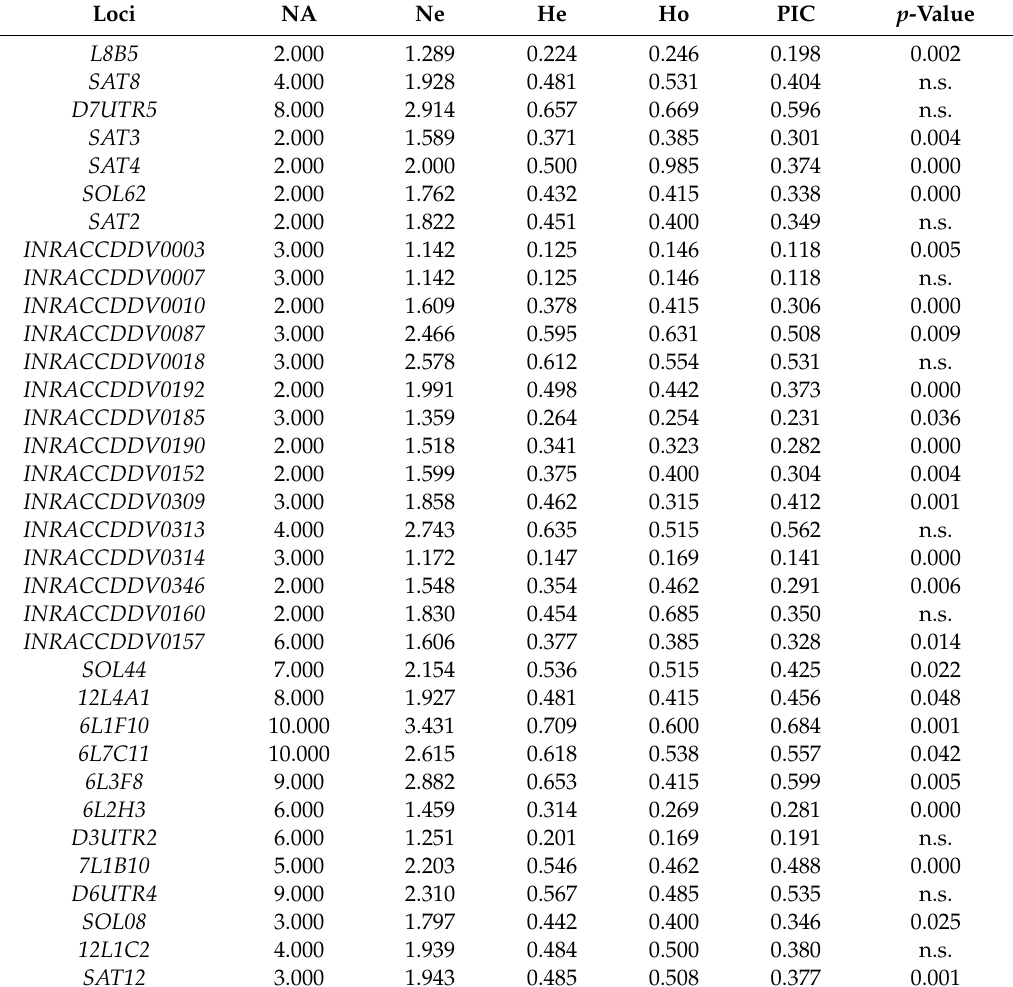
Table1. Numberofalleles(NA),e ff ectivenumberofalleles(Ne), expectedheterozygosity(He), observed heterozygosity (Ho), Polymorphism Information Content (PIC), and Hardy–Weinberg Equilibrium values ( p -values) at the 43 best simple sequence repeat (SSR)